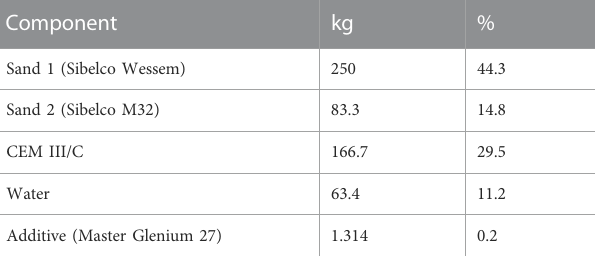
TABLE 1 Composition of the CILVA immobilization matrix, for a volume of approximately 250